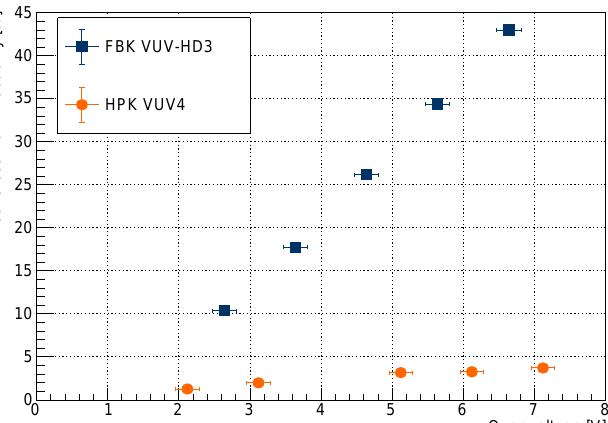
Figure 8. Direct cross-talk probability (DiCT) as a function of the applied over-voltage measured at 163K for the two SiPMs tested in this work [6,18]. The DiCT probability is measured as the ratio between the number of prompt (or trigger) pulses with an integrated charge bigger than 1.5 Photo- electron Equivalent (PE) divided by the number of prompt pulses with an integrated charge bigger than 0.5